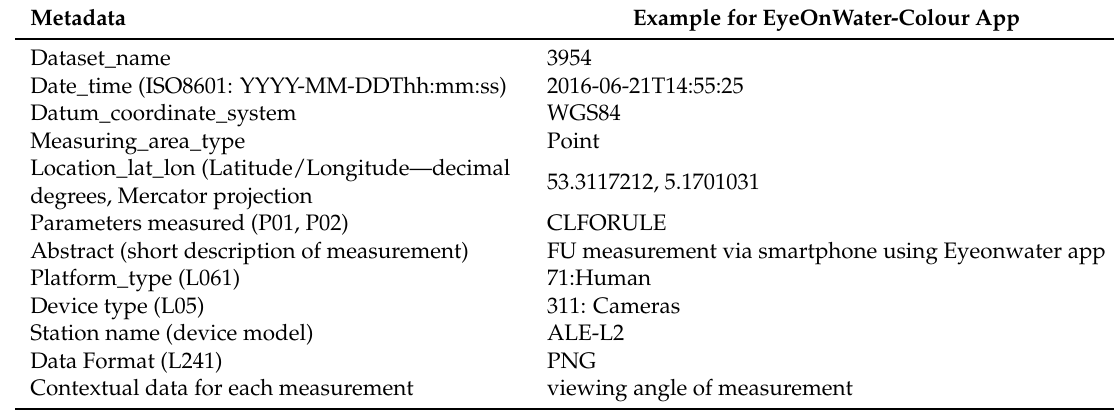
Table 3. Metadata that are automatically added to Citclops/EyeOnWater measurements to facilitate ease of uploading to international data